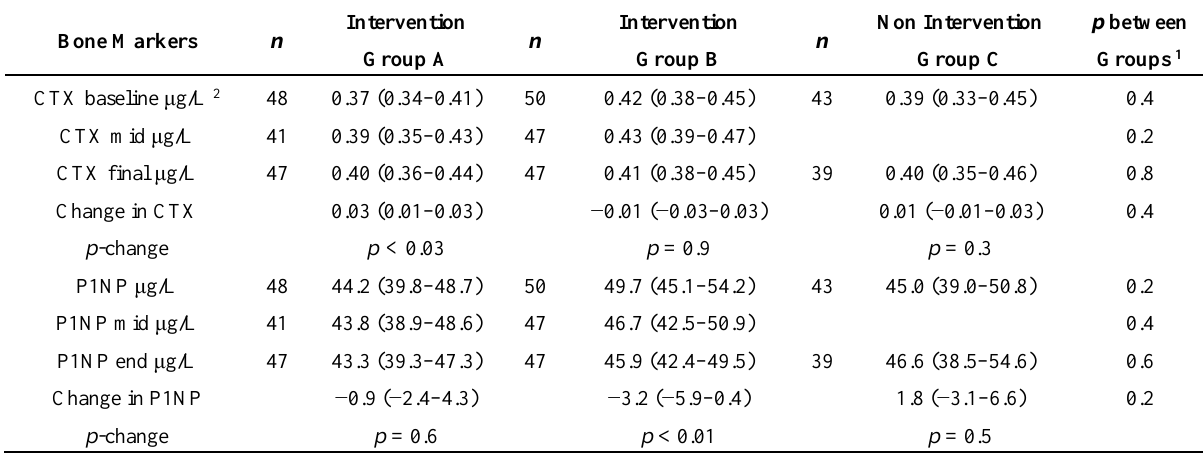
Table 6. Changes in bone markers within each group.